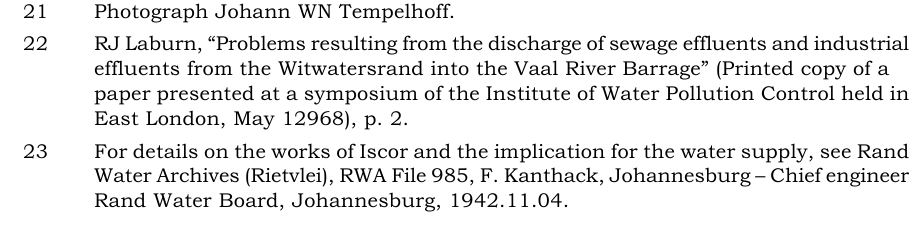
TD , 3(1), July 2007, pp. 107-133.